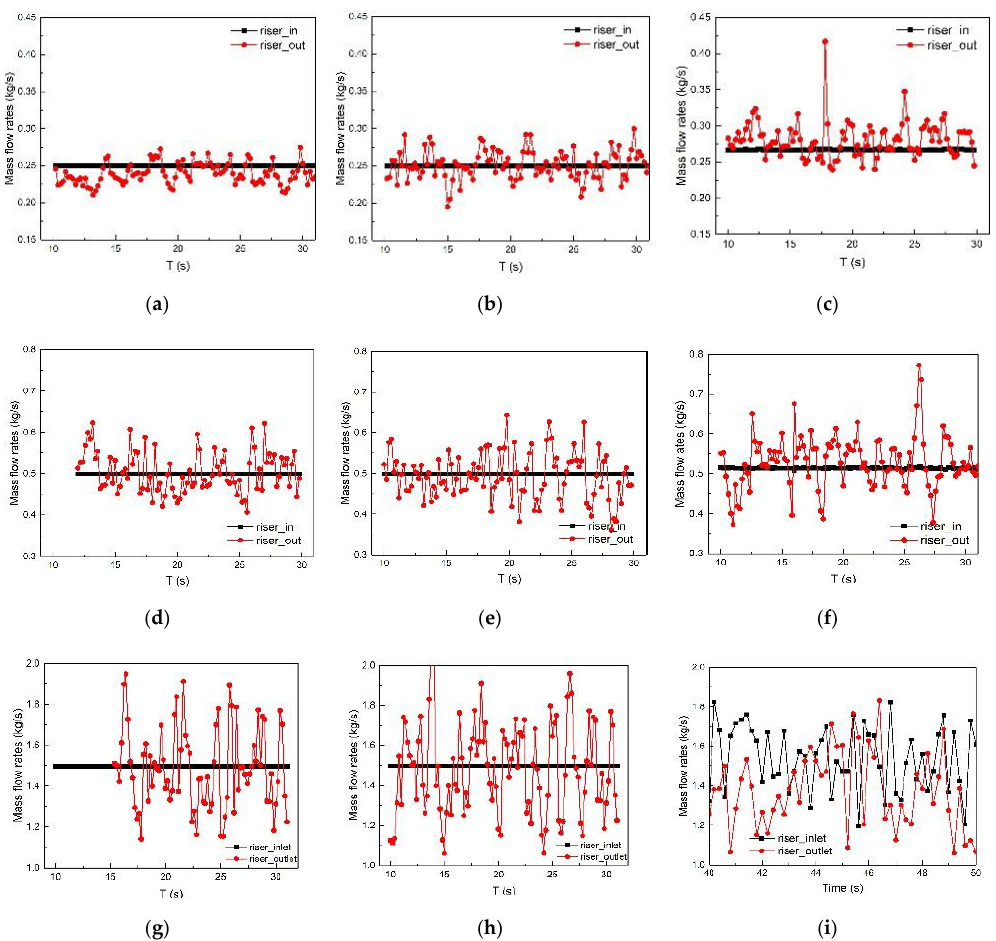
Figure 13. Comparison of solids circulating rates in entrance and exit of riser between two methods. ( a ) Riser-simplified simulation in U g = 7 m s − 1 , G s = 50 kg m − 2 s − 1 ; ( b ) riser-only simulation in U g = 7 m s − 1 , G s = 50 kg m − 2 s − 1 ; ( c ) full-loop simulation in U g = 7 m s − 1 , G s = 50 kg m − 2 s − 1 ; ( d ) riser-simplified simulation in U g = 7 m s − 1 , G s = 100 kg m − 2 s − 1 ; ( e ) riser-only simulation in U g = 7 m s − 1 , G s = 100 kg m − 2 s − 1 ; ( f ) full-loop simulation in U g = 7 m s − 1 , G s = 100 kg m − 2 s − 1 ; ( g ) riser-simplified simulation in U g = 7 m s − 1 , G s = 300 kg m − 2 s − 1 ; ( h ) riser-only simulation in U g = 7 m s − 1 , G s = 300 kg m − 2 s − 1 ; ( i ) full-loop simulation in U g = 7 m s − 1 , G s = 300 kg m − 2 s − 1